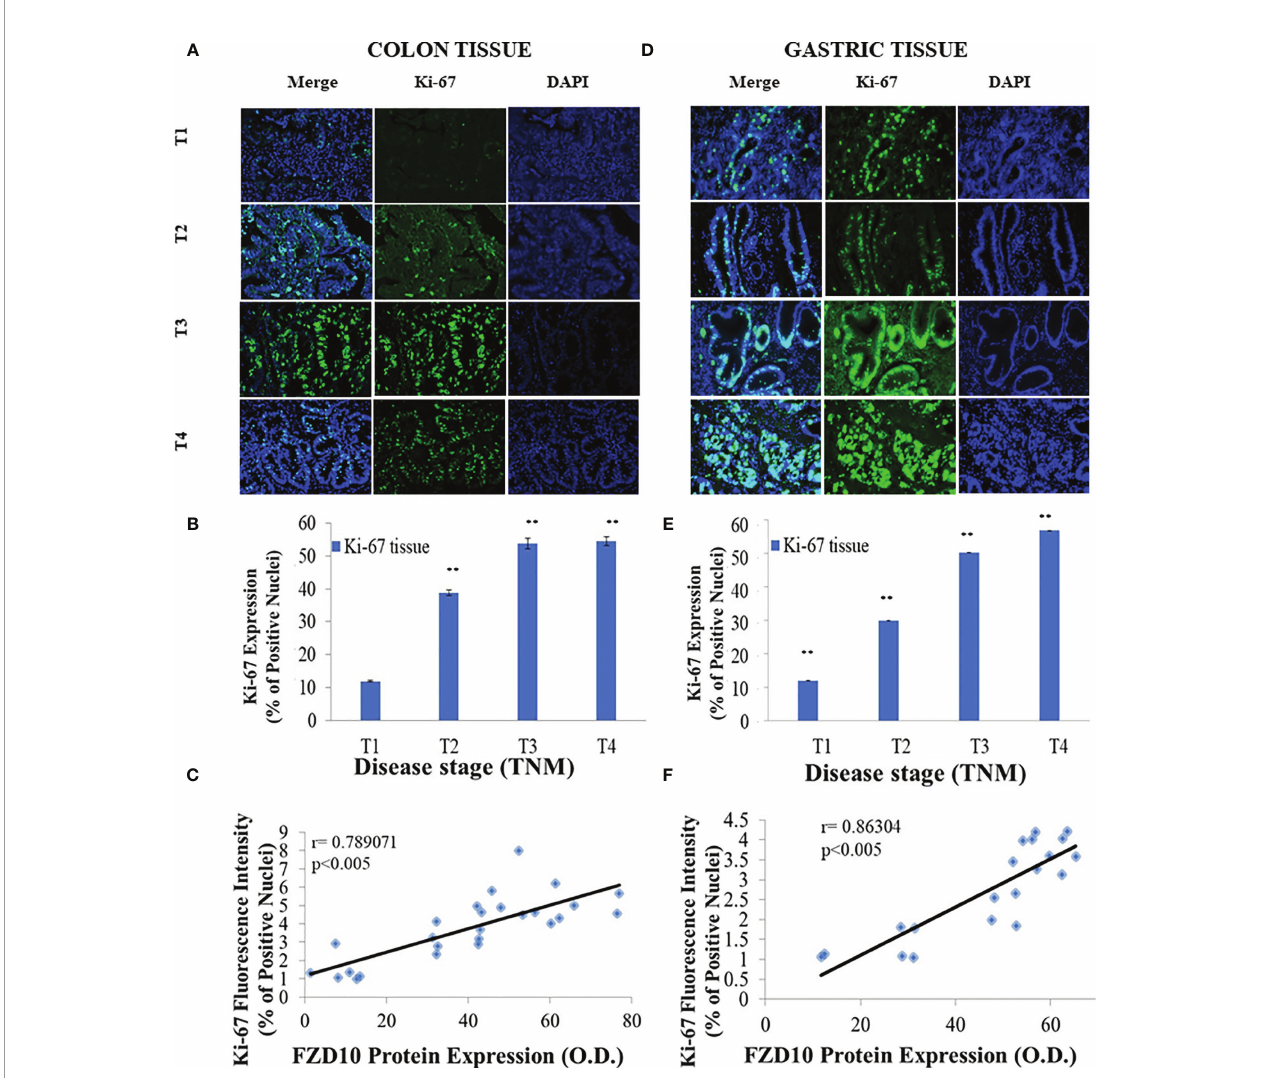
FIGURE 6 | Evaluation of Ki-67 expression levels in tissues derived from (26) colorectal cancer (CRC) or (20) gastric cancer (GC) patients and correlation between Ki-67 in tissues and Frizzled (FZD)10 expression in exosomes. Representative confocal microscopy images for the detection of Ki-67+ nuclei (green) in tissues from CRC (A) or GC (D) patients at different TNM stages. Blue channel: nuclei; green channel: labeled Ki-67 and corresponding overlay. Scale bar, 50 µm; Magni fi cation, ×20 (A, D) . Ki-67 expression levels, quantitatively evaluated by immuno fl uorescence intensity index, in CRC (B) and GC (E) tissues at different TNM stages. (**) p < 0.001 vs . T1 subject (B, E) . Pearson ’ s correlations between expression levels of FZD10 in exosomes evaluated by Western blotting analysis and Ki-67 in CRC (C) or GC (F) tissues evaluated by immuno fl uorescence analysis p < 0.005 vs . stage T1 (C, F)